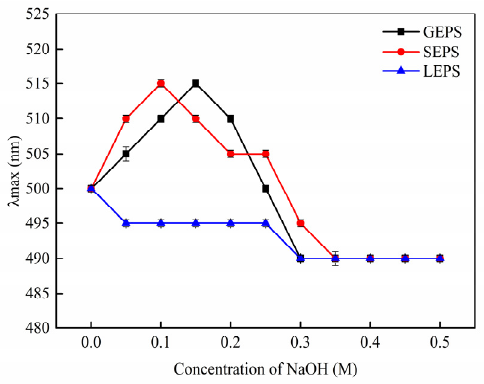
Figure 3. Maximum absorption ( λ max) of Congo red + EPS at various NaOH concentrations.